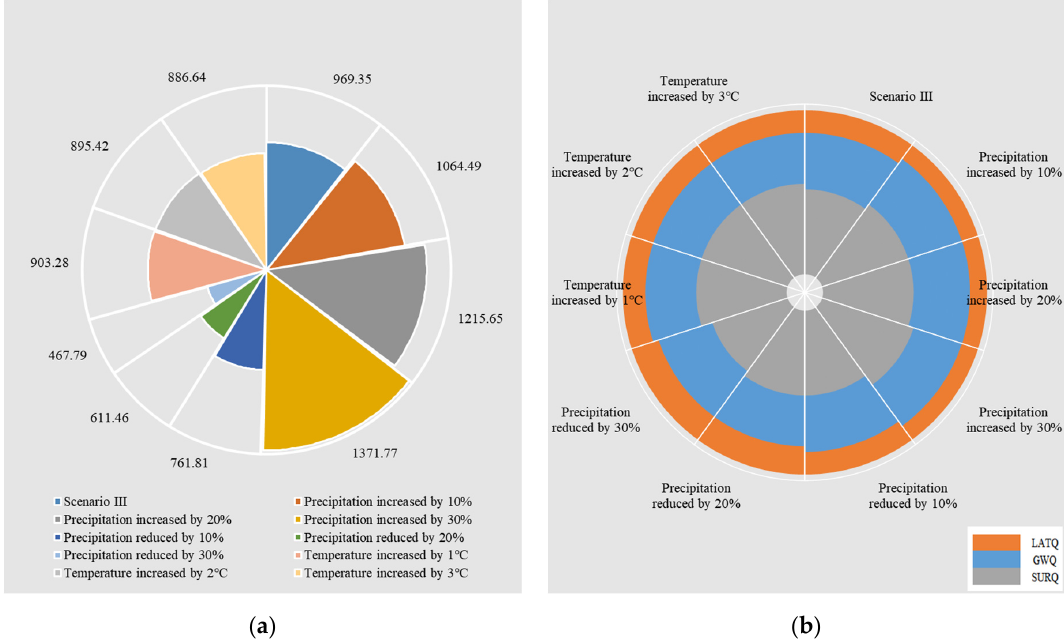
Figure 10. Simulation of the annual mean values (mm year − 1 ) of BWF ( a ) and the proportions of its components (SURQ, LATQ, GWQ) ( b ) in the upper Ganjiang River basin by individual altered precipitation and temperature factors based on Scenario III.